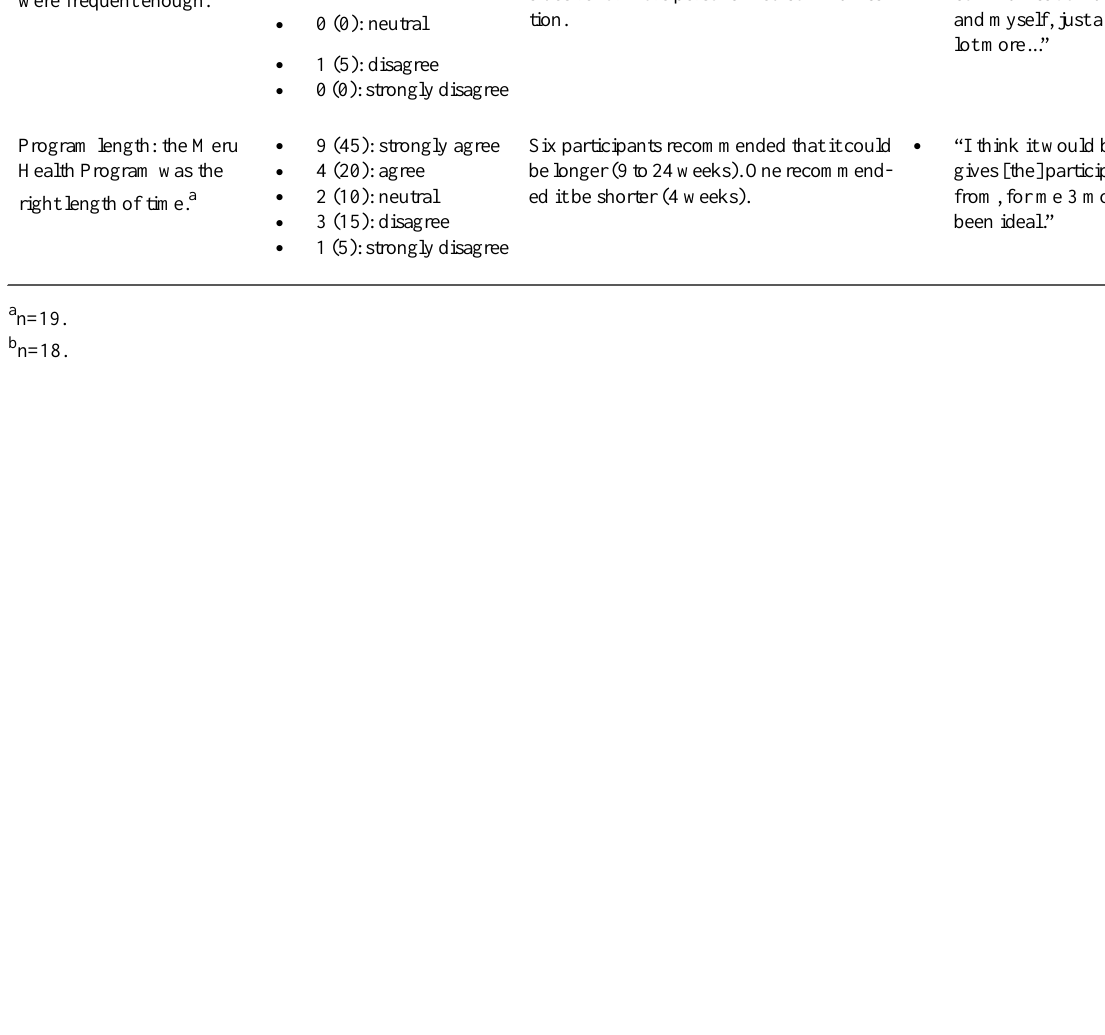
Challenges included difficulty